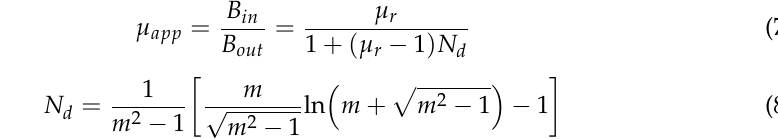
Figure 3. Equivalent circuit of the search coil with matching resistor ( a ) and its frequency response ( b ).